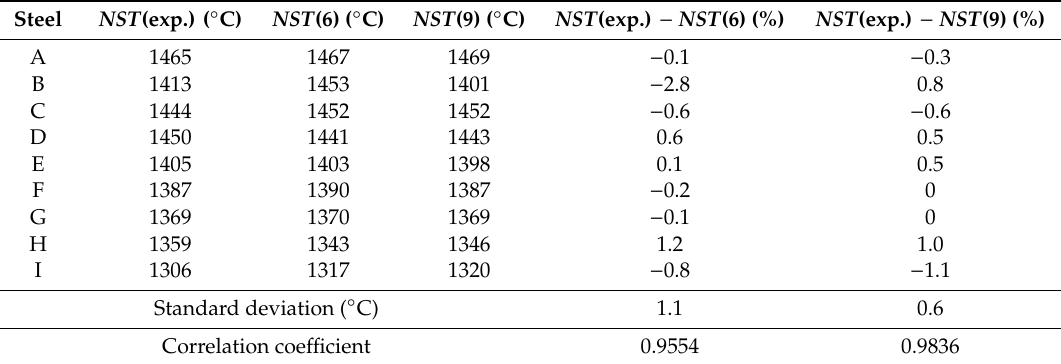
Table 5. Evaluation of accuracy of Equations (6) and (9) intended for the calculation of the nil-strength temperatures of the investigated steels. Table 6. Evaluation of accuracy of Equations (7) and (10) intended for the calculation of the zero strength temperatures of the investigated